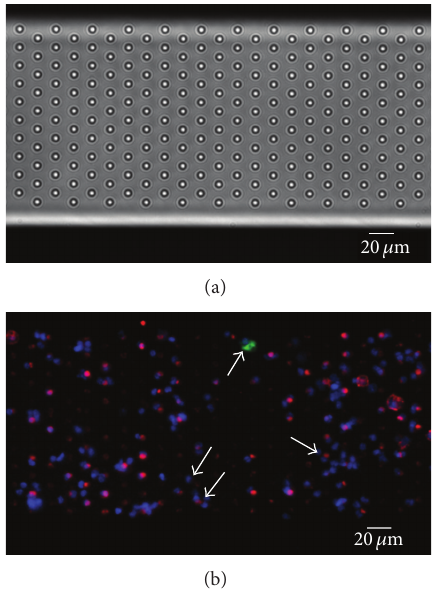
Figure 5: Cells from CellSearch Waste immunostained on a microsieve. Blood from a lung cancer patient was used for a CellSearch assay. After immunomagnetic selection, part of the sample was discarded by the system and used for filtration on a microsieve with 5 𝜇 m pores. Bright-field image of the sieve is shown in (a). (b) shows the sieve with filtered sample. Cells were stained for nucleus (blue), cytokeratin C11 (green), and CD45 (red). Fat arrow points to a CTC, positive in CK. Small arrows point to the absent staining of cells, showing the difficulty of accounting for all cells on the sieve. Image taken on a fluorescence microscope with a 10x (0.45NA) objective.